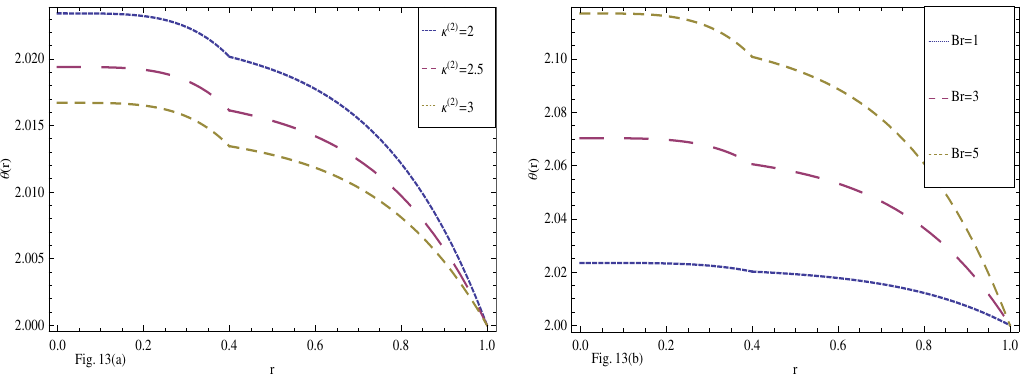
Figure 12. Variation of ( a ) (cid:101) ( 2 ) and ( b ) κ ( 1 ) on the temperatures of the two fluids.